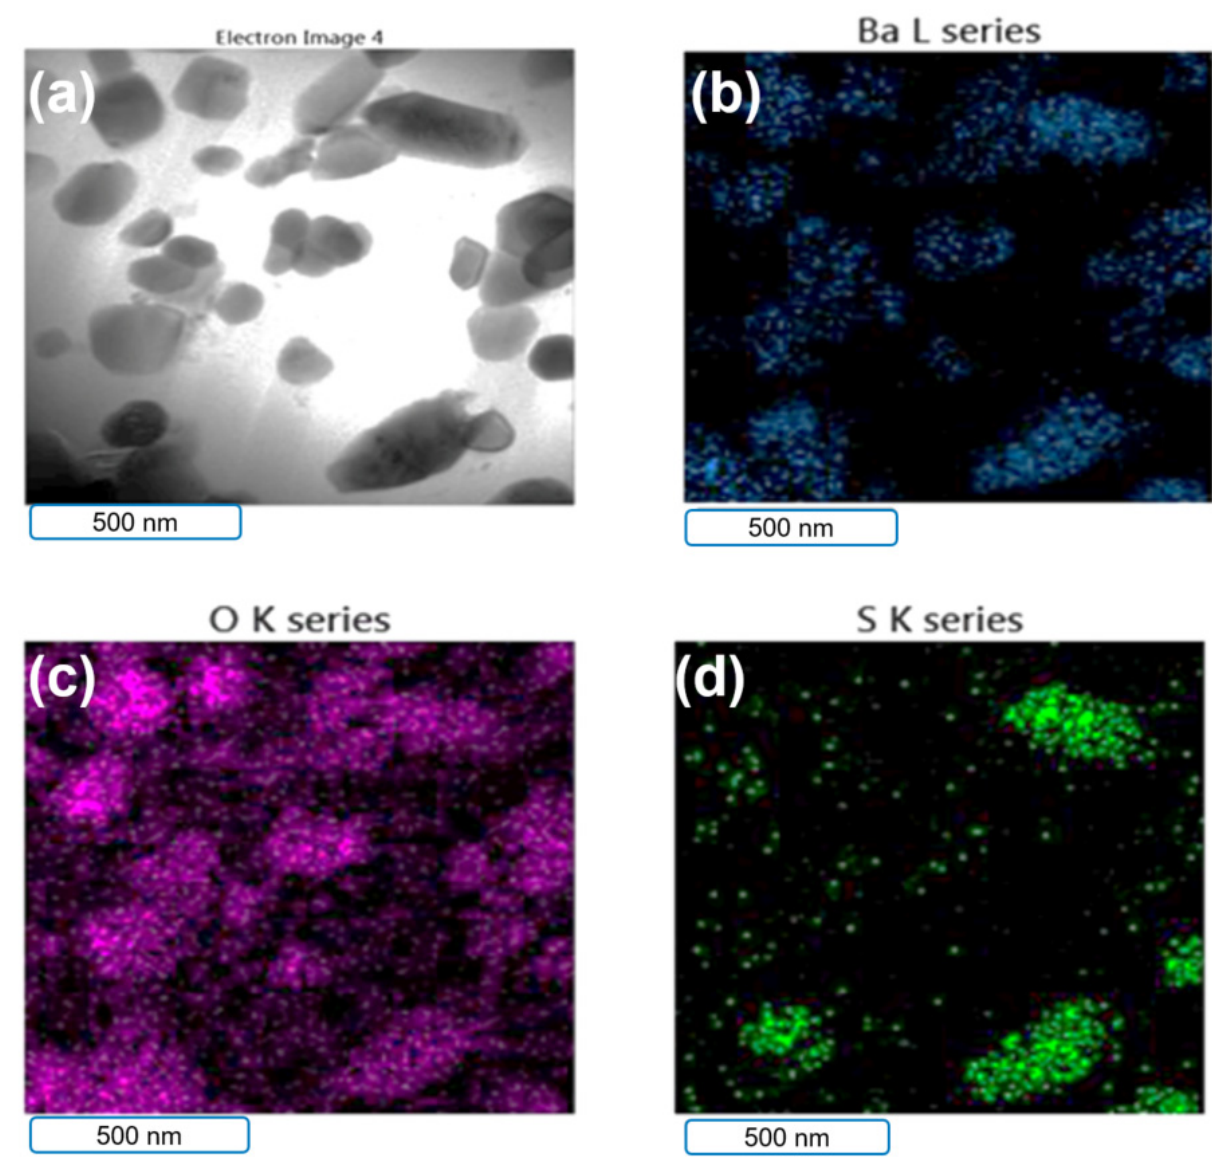
Figure 3. TEM/EDS analysis results for B–epoxy matrix. ( a ) secondary-electron image, ( b ) Ba elements mapping, ( c ) oxygen element mapping, ( d ) sulfur element mapping.